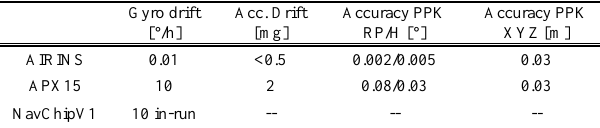
Table 2: IMU manufacturer